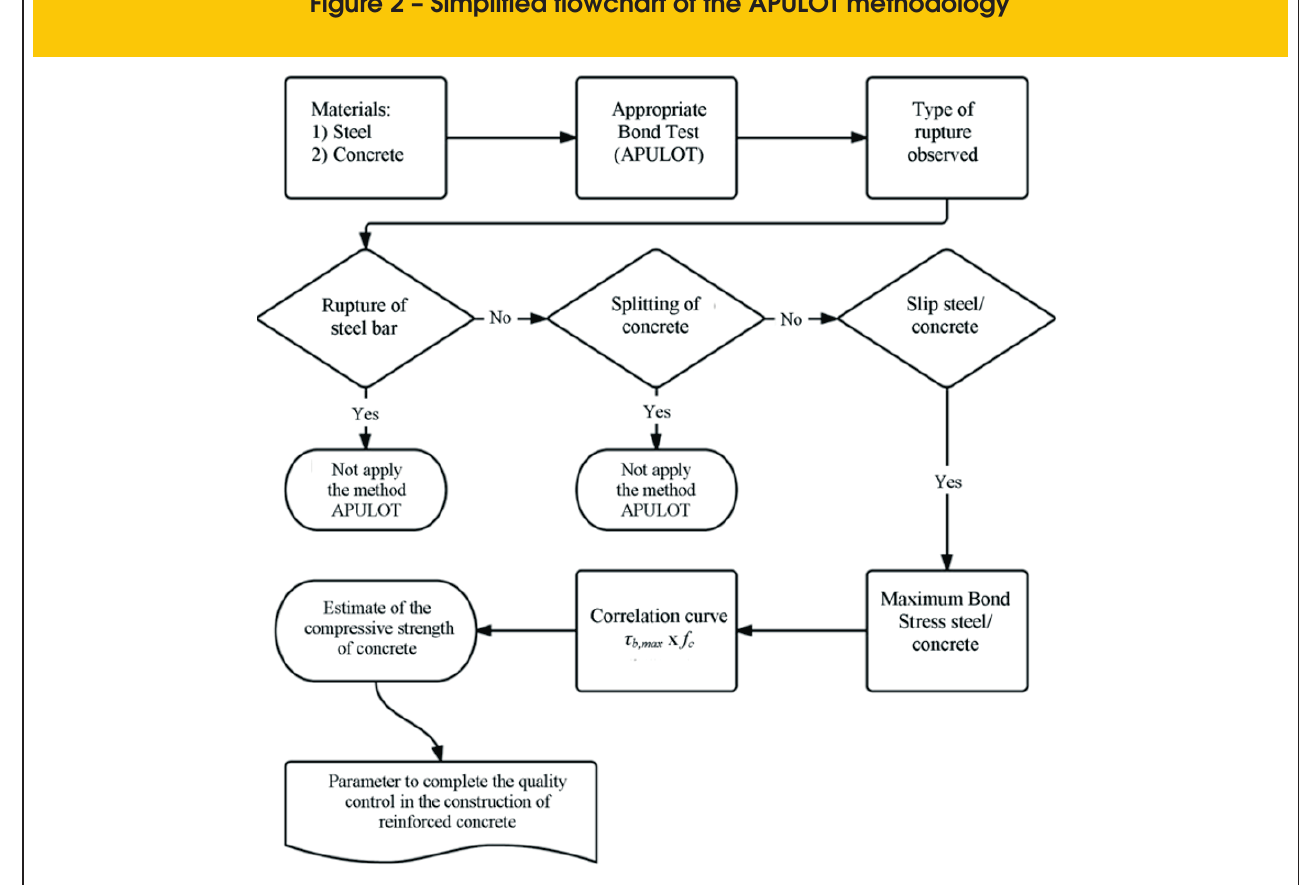
Figure 2 – Simplified flowchart of the APULOT